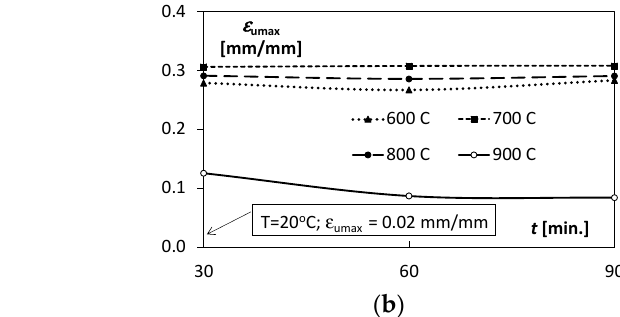
Figure 8. Dependence of the uniform plastic deformation value ε u annealing time t .